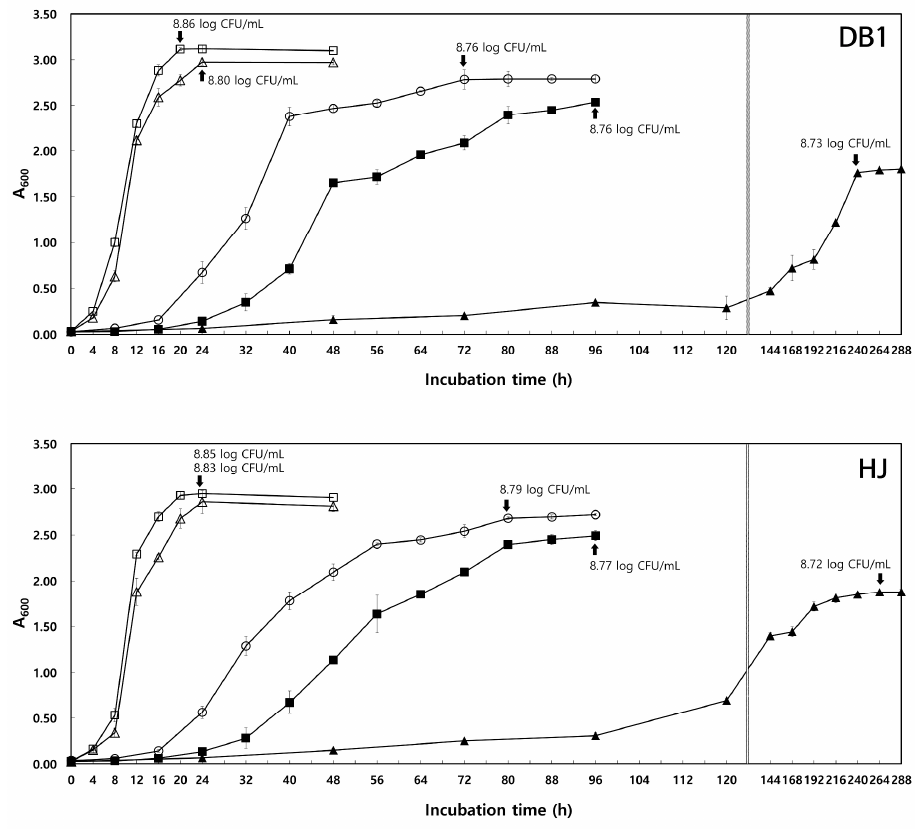
Figure 1. Growth of LAB at different temperatures. W. koreensis DB1 and HJ were incubated in MRS broth at 5 °C ( ▲ ), 10 °C ( ■ ),15 °C ( ○ ), 25 °C ( △ ), or 30 °C ( □ ) for 24–288 h.